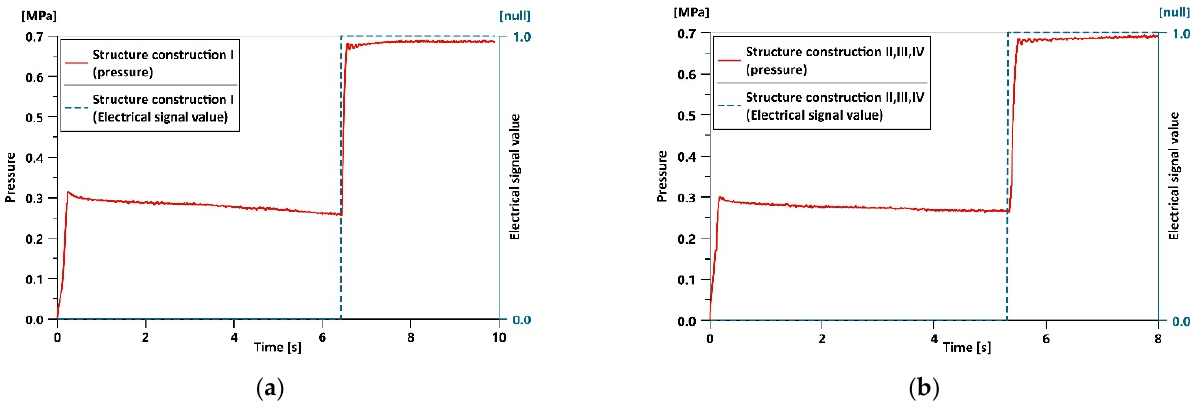
Figure 10. Results of the switch test between the manual control mode and electronic control mode during pressurization: